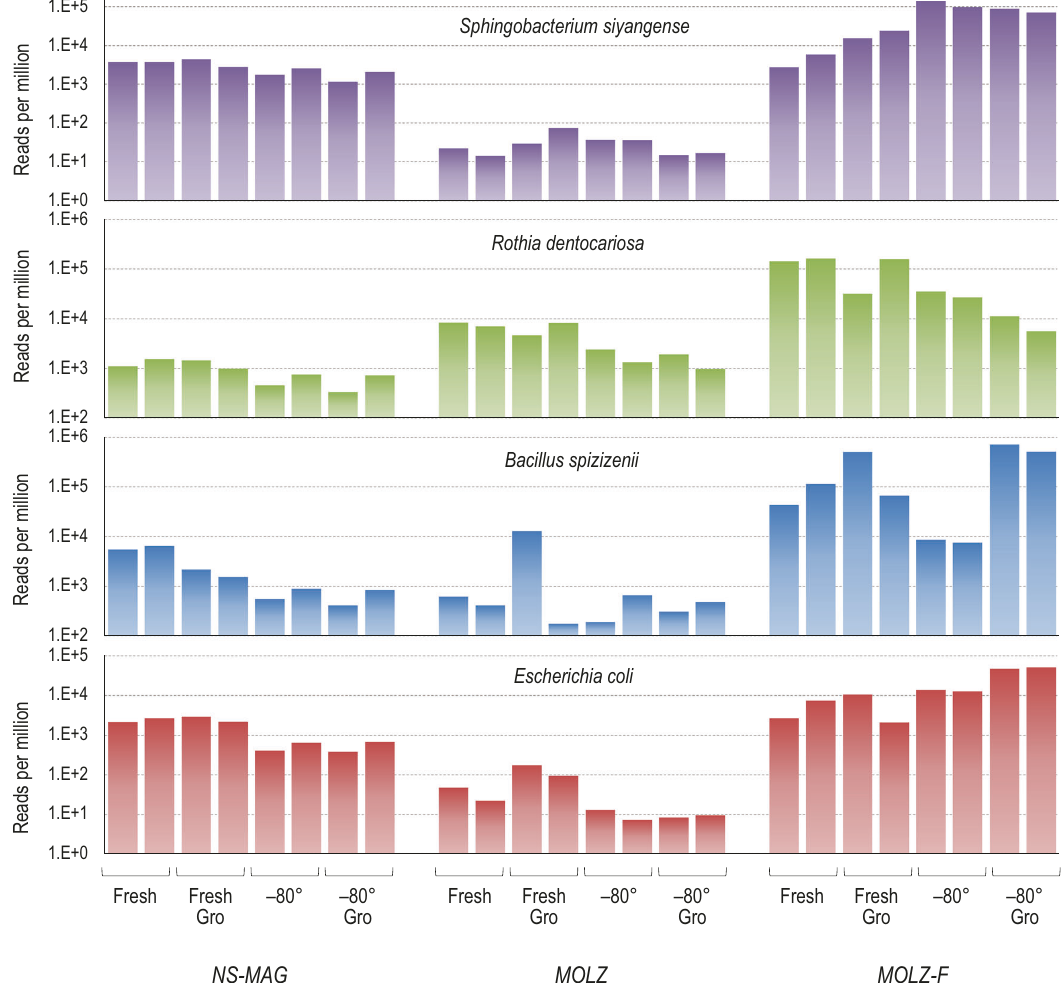
Fig. 2 Read counts of the four spike-in organisms normalized per million of quality fi ltered read pairs. For each bacterial species, we calculated the average for the number of forward and reverse reads mapping by USEARCH to relevant genome sequence